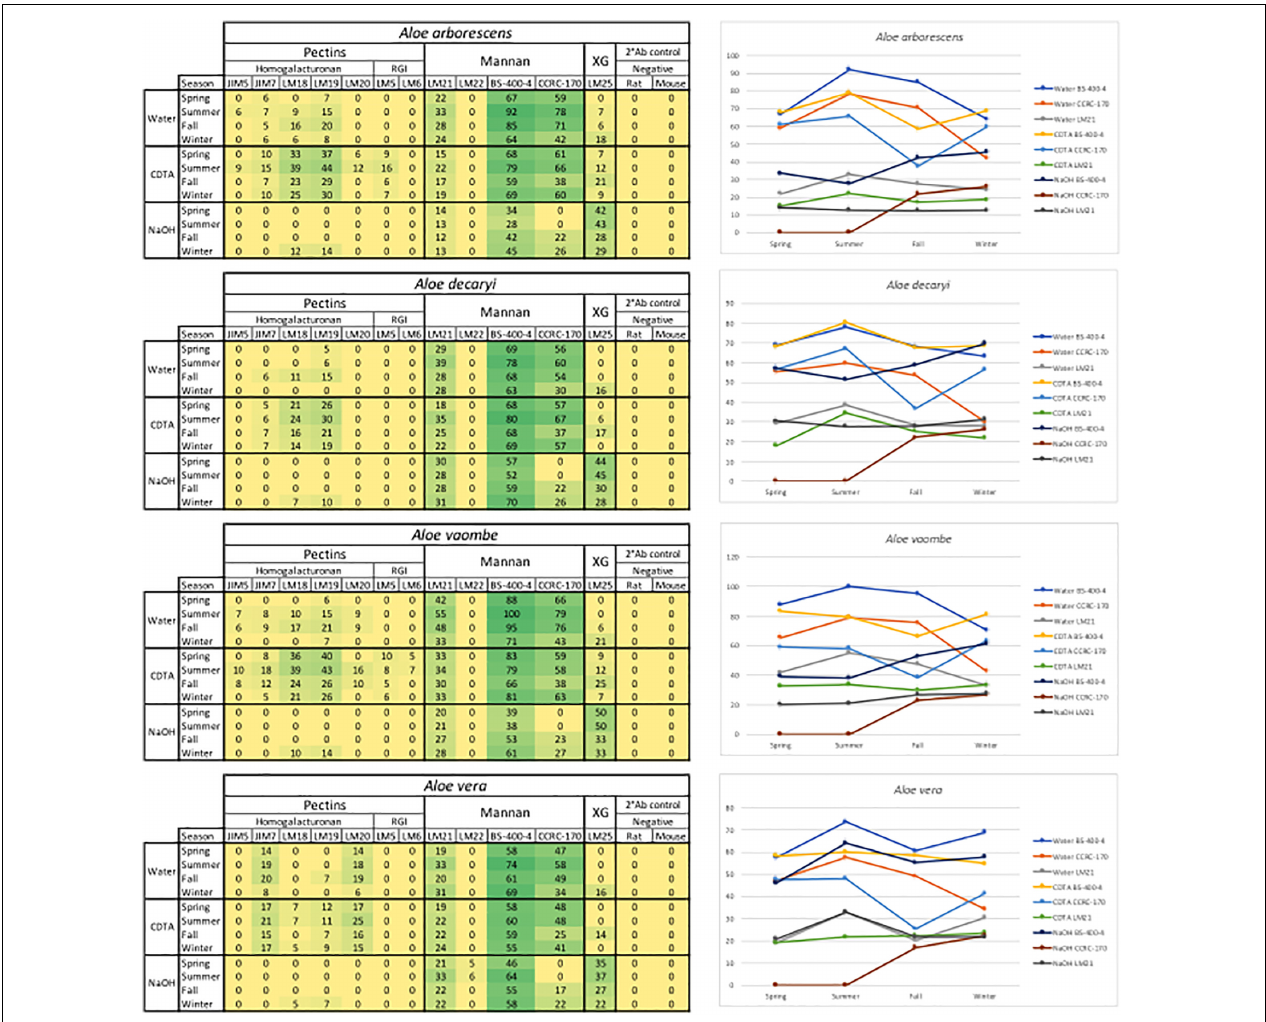
FIGURE 6 | Species specific heatmaps and graphs showing the changes in mannan over time in the three sequential extractions. RGI, rhamno-galacturonan; XG, xyloglycan; Meg. R, anti-rat; Neg. M, anti-mouse. The highest mean value of the entire dataset was assigned the value of 100%, and the remainder of the data were adjusted accordingly and normalized with a 5% cut off (represented with a zero –